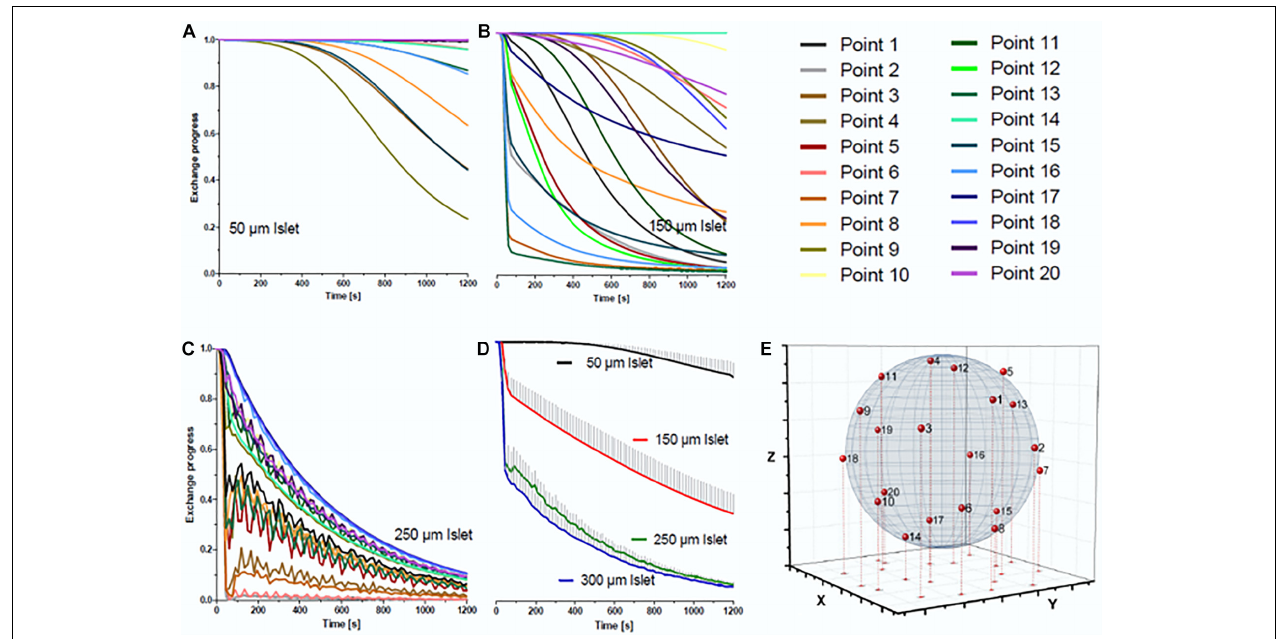
FIGURE 5 | Simulation of the medium exchange at 37 ◦ C at the surface of islets of different diameters. For the simulation 20 points were evenly distributed over the surface of spheroidal islets of different diameter. The line color codes for the position of the point of simulated measurement, the color code is the same for all islets. The diagrams show the decrease of the pre-existent medium on the surface of (A) an islet of 50 µ m diameter, (B) an islet of 150 µ m diameter, and (C) an islet of 250 µ m diameter. The time-dependent decrease of the mean value of all 20 measuring points is given in (D) for these three islets and, additionally, for an islet of 300 µ m diameter. It becomes clear that the exchange process is substantially faster for islets of 250 µ m than for those of 150 µ m diameter, but does not accelerate much further with larger islets. The effect of diffusional exchange between the media was not included in the simulation. (E) Distribution of the 20 simulation points over the surface of an ideal spheroidal